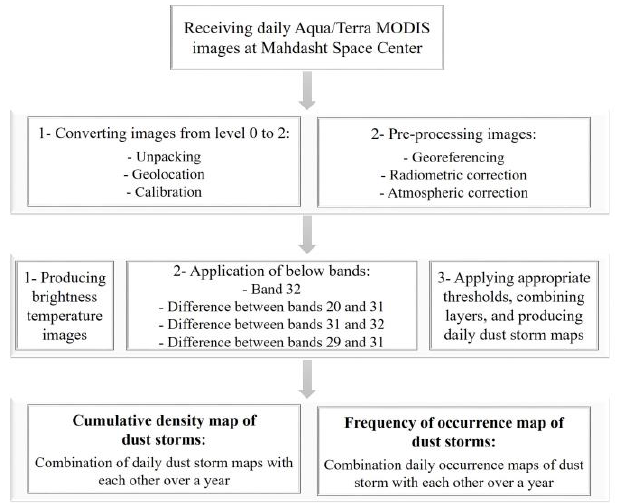
Figure 2. Flowchart of the proposed methodology